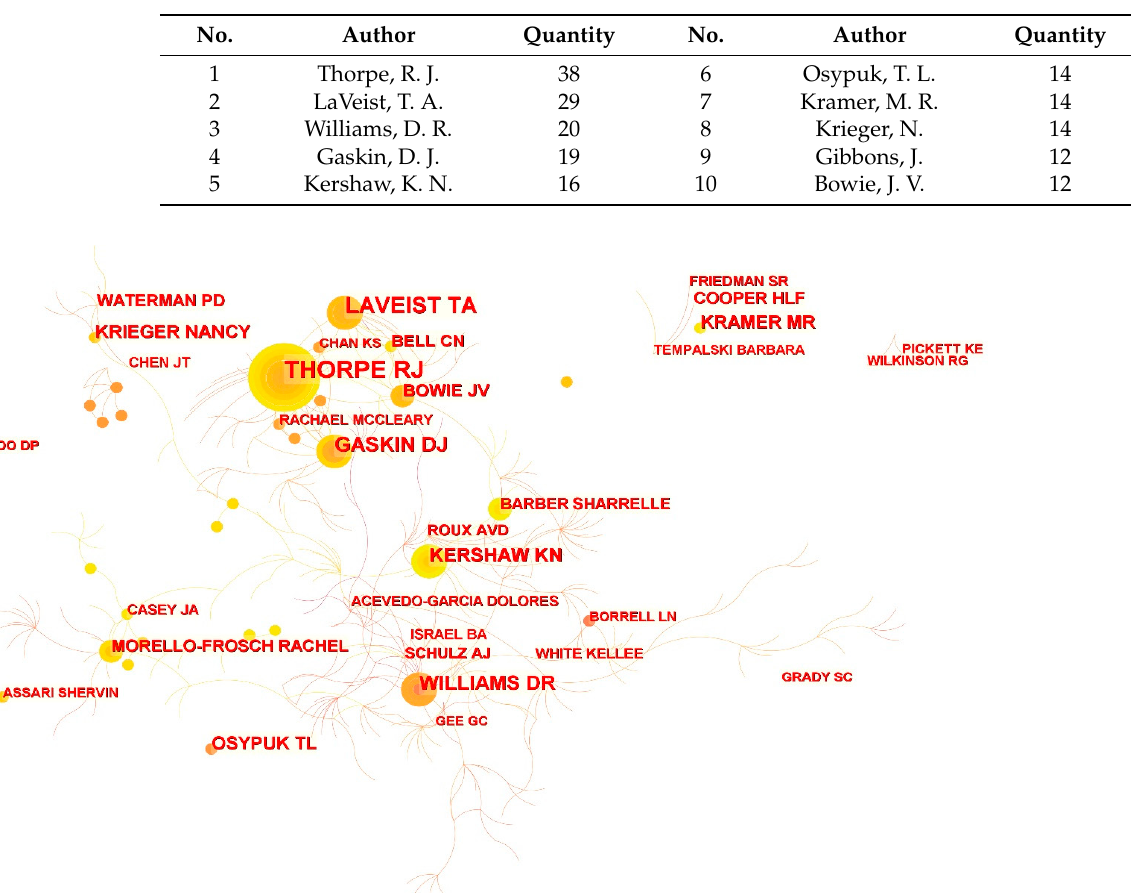
Table 2. Top 10 productive authors in RSH research.